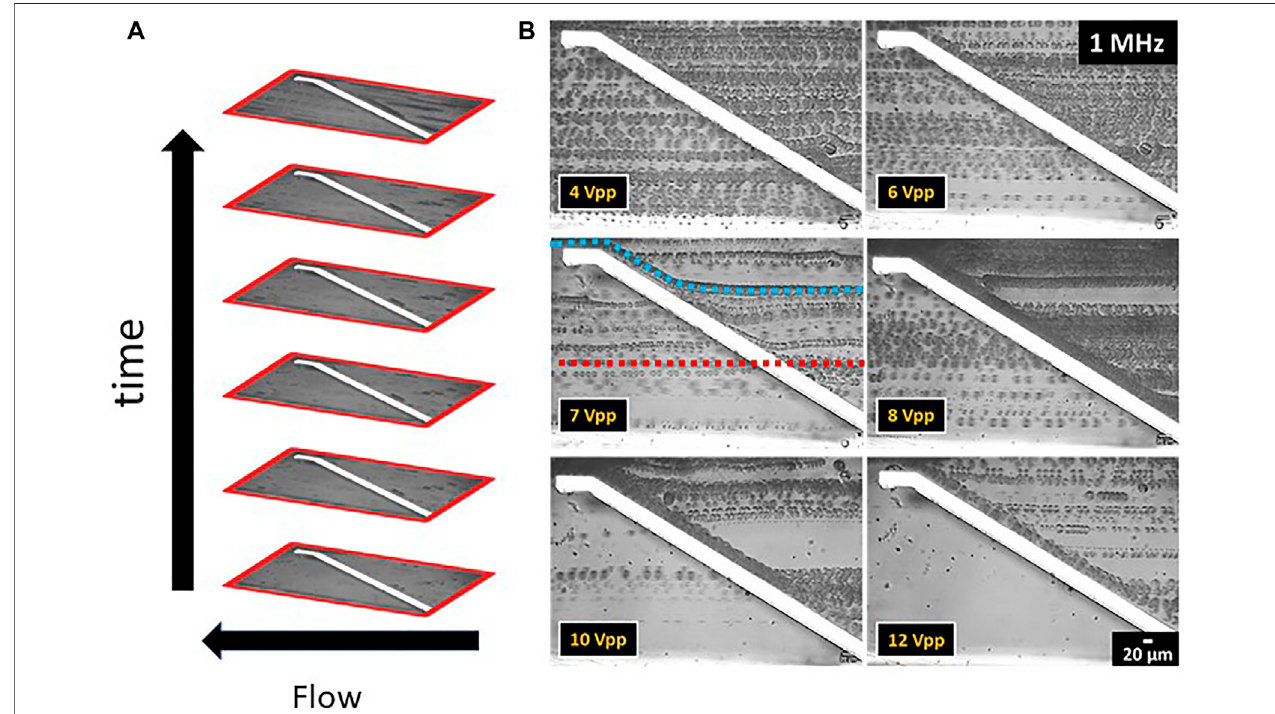
FIGURE7| t stackpicturesof C.cohnii microalgaecellsinamicro fl uidic channelwithtop-bottom electrodes. Thedirectionof fl owisfromrighttoleft. (A) Detailed t stack picture format presenting the vertical placementofthephoto framesover time. (B) t stack pictures ofthetop-bottom electrode structure showing thebehaviourof C. cohnii cellsto theDEP fi eld for aconstant frequency at 1 MHz and an amplitude range between4 – 12V pp .Each celllinerepresentsthe monitored fl owofan individual cellasitapproachestheelectrodepairand fl owsawayfromit.Examplesaregiveninthe fi gurefor7V pp ,wherethemodeltrajectoriesforanunde fl ectedcell(redline in the middle) and a DEP-de fl ected cell (blue line on top) are